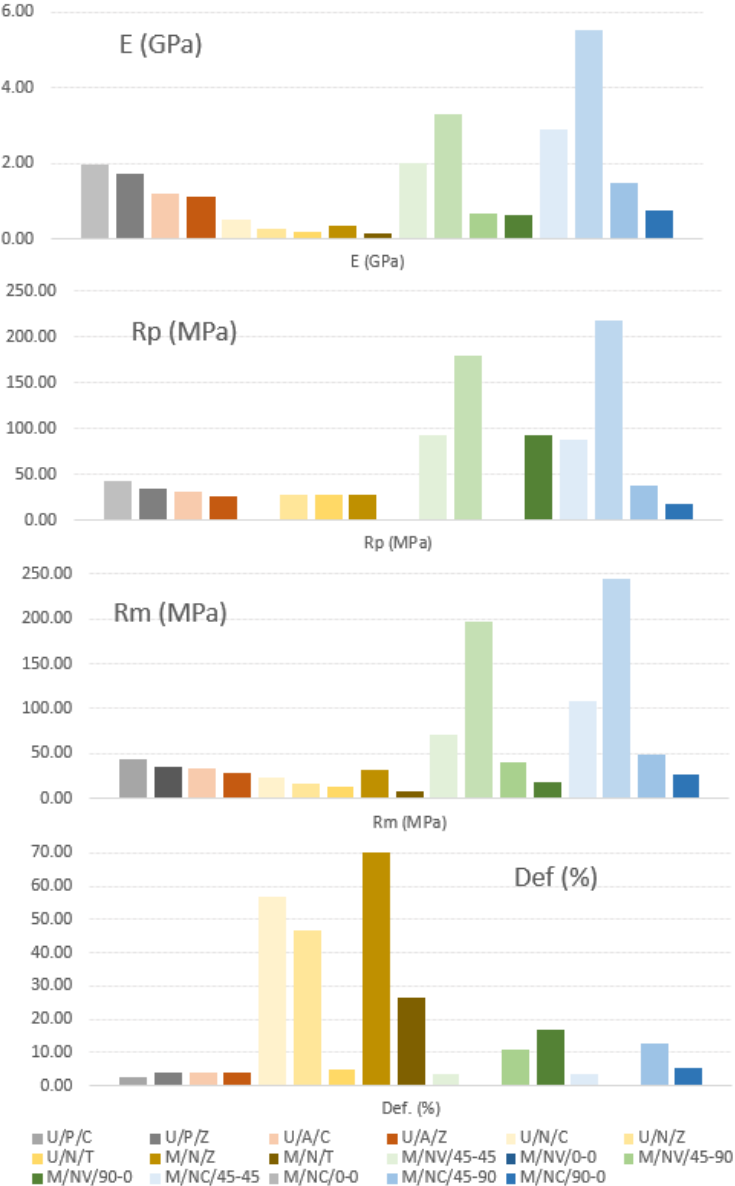
Figure 26. Average E (GPa), Rp (MPa), Rm (MPa), and Def (%) values of PLA/ABS/Nylon